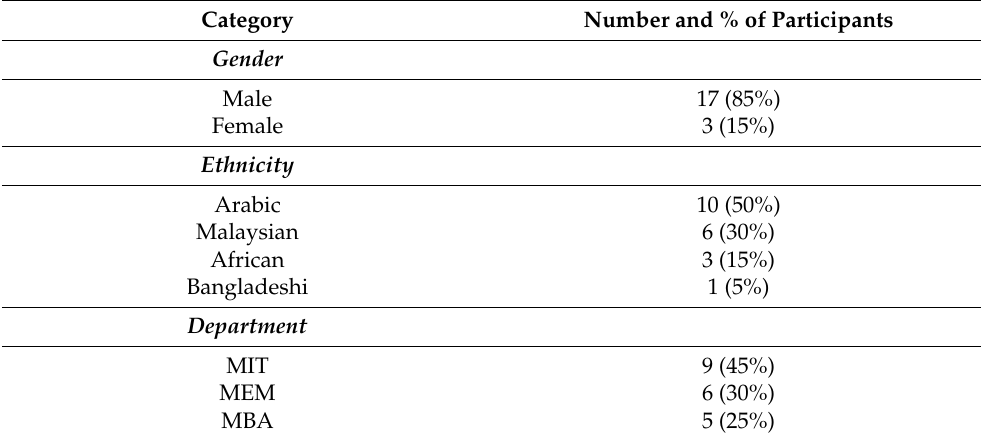
Table 2. Characteristics of the FGD